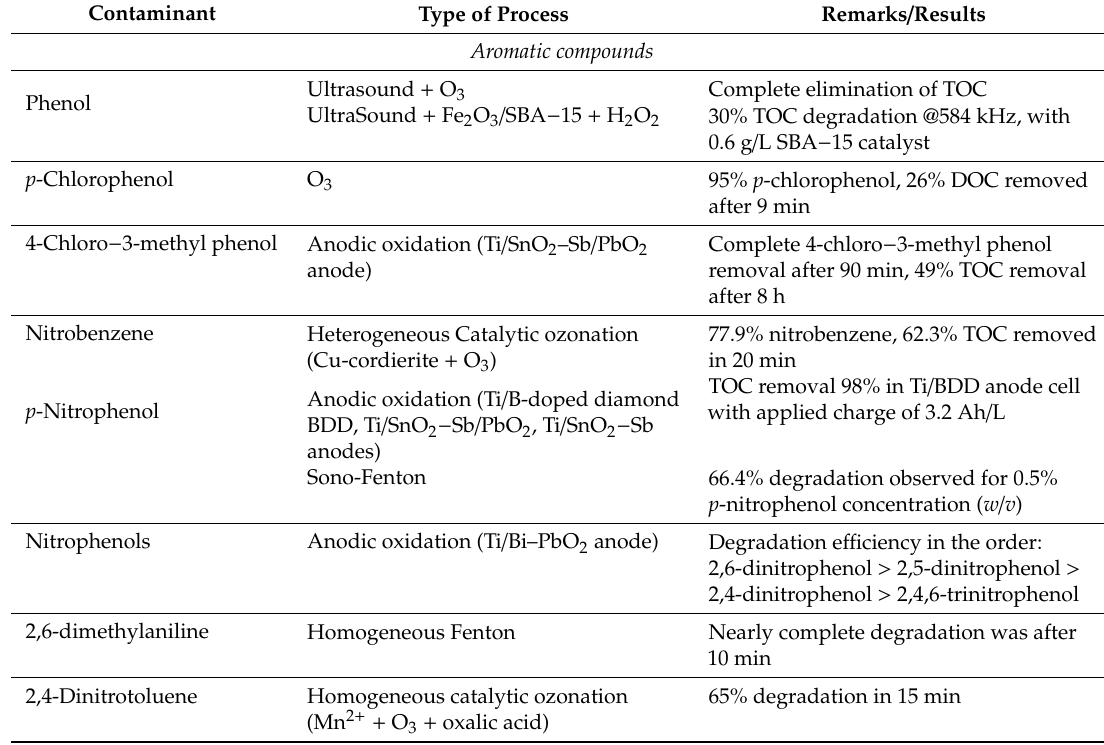
Table 6. Application of AOPs for the removal of di ff erent types of compounds (data from [18]). Contaminant Type of Process Remarks /